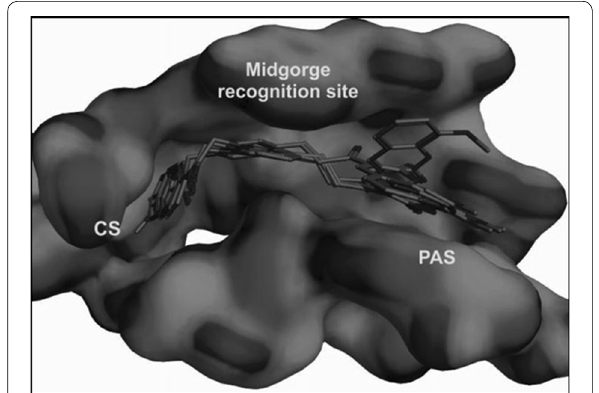
Fig. 34 Superimpositions of the best-docked poses of coumarin analogues in the AChE binding site